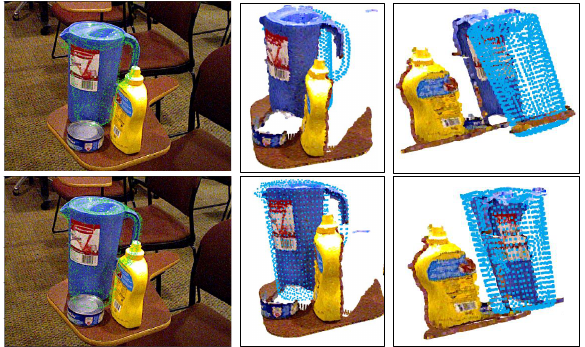
Figure 1. The Translation Error in Holistic Models. The first row shows translation errors in PoseCNN [20]. The second row shows examples of our model. It is difficult to show translation error from the 2D projection images. Therefore, we present the object in 3D point cloud from different perspectives. The blue point clouds are the predicted results. We found that our model performs better in